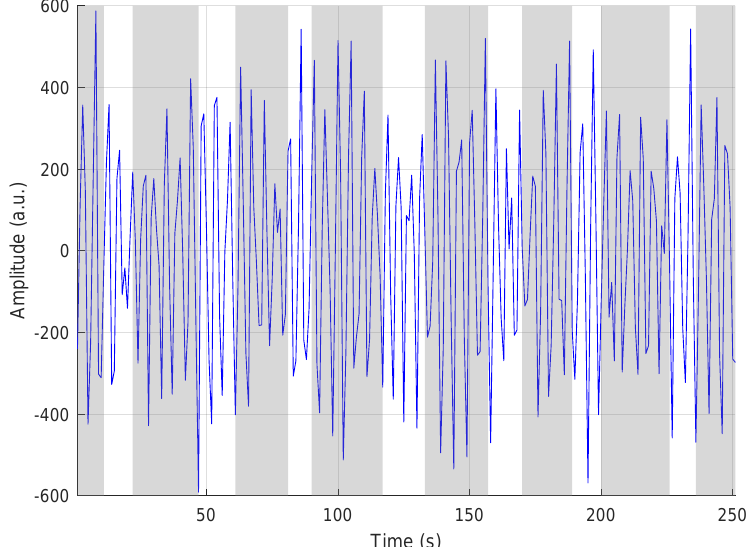
Figure 3. Non-sparse solution obtained by minimization of || y − X β || 2 in the same segment of the signal as in Figure 2; the greyed areas correspond to ground-truth